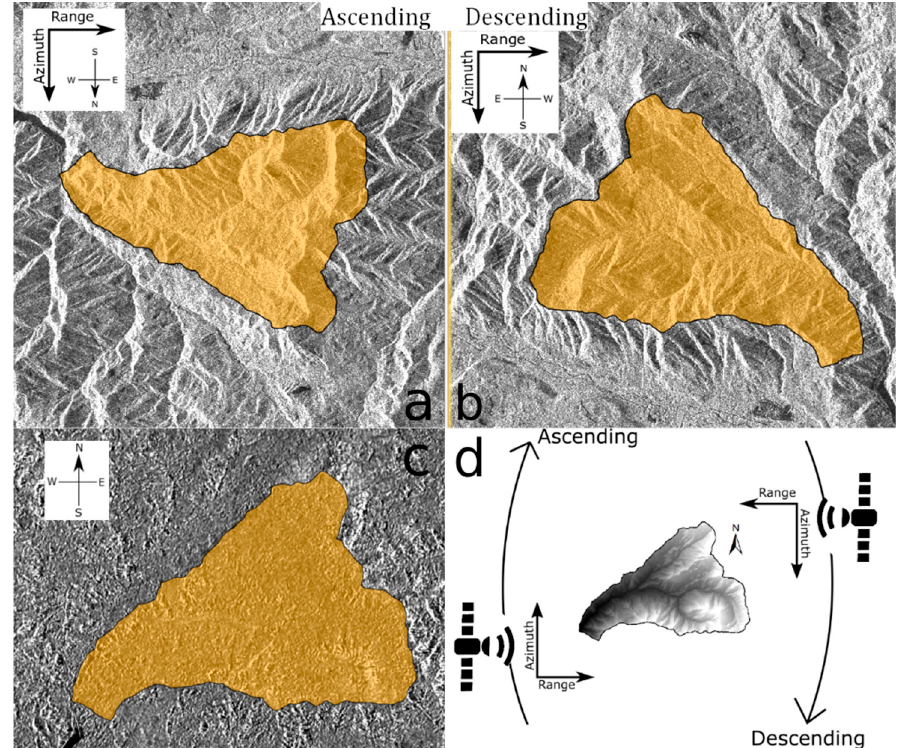
Figure 4. Raw ( a , b ) and Processed with ESA Sentinel-1 tools ( c ) radar images. Note the raw images are geographically inverted due to the data acquisition process shown in ( d ). The columns of each raw image correspond to increasing the range distance from the spacecraft, whereas the rows of each image correspond to the spacecraft movement along its orbital track.